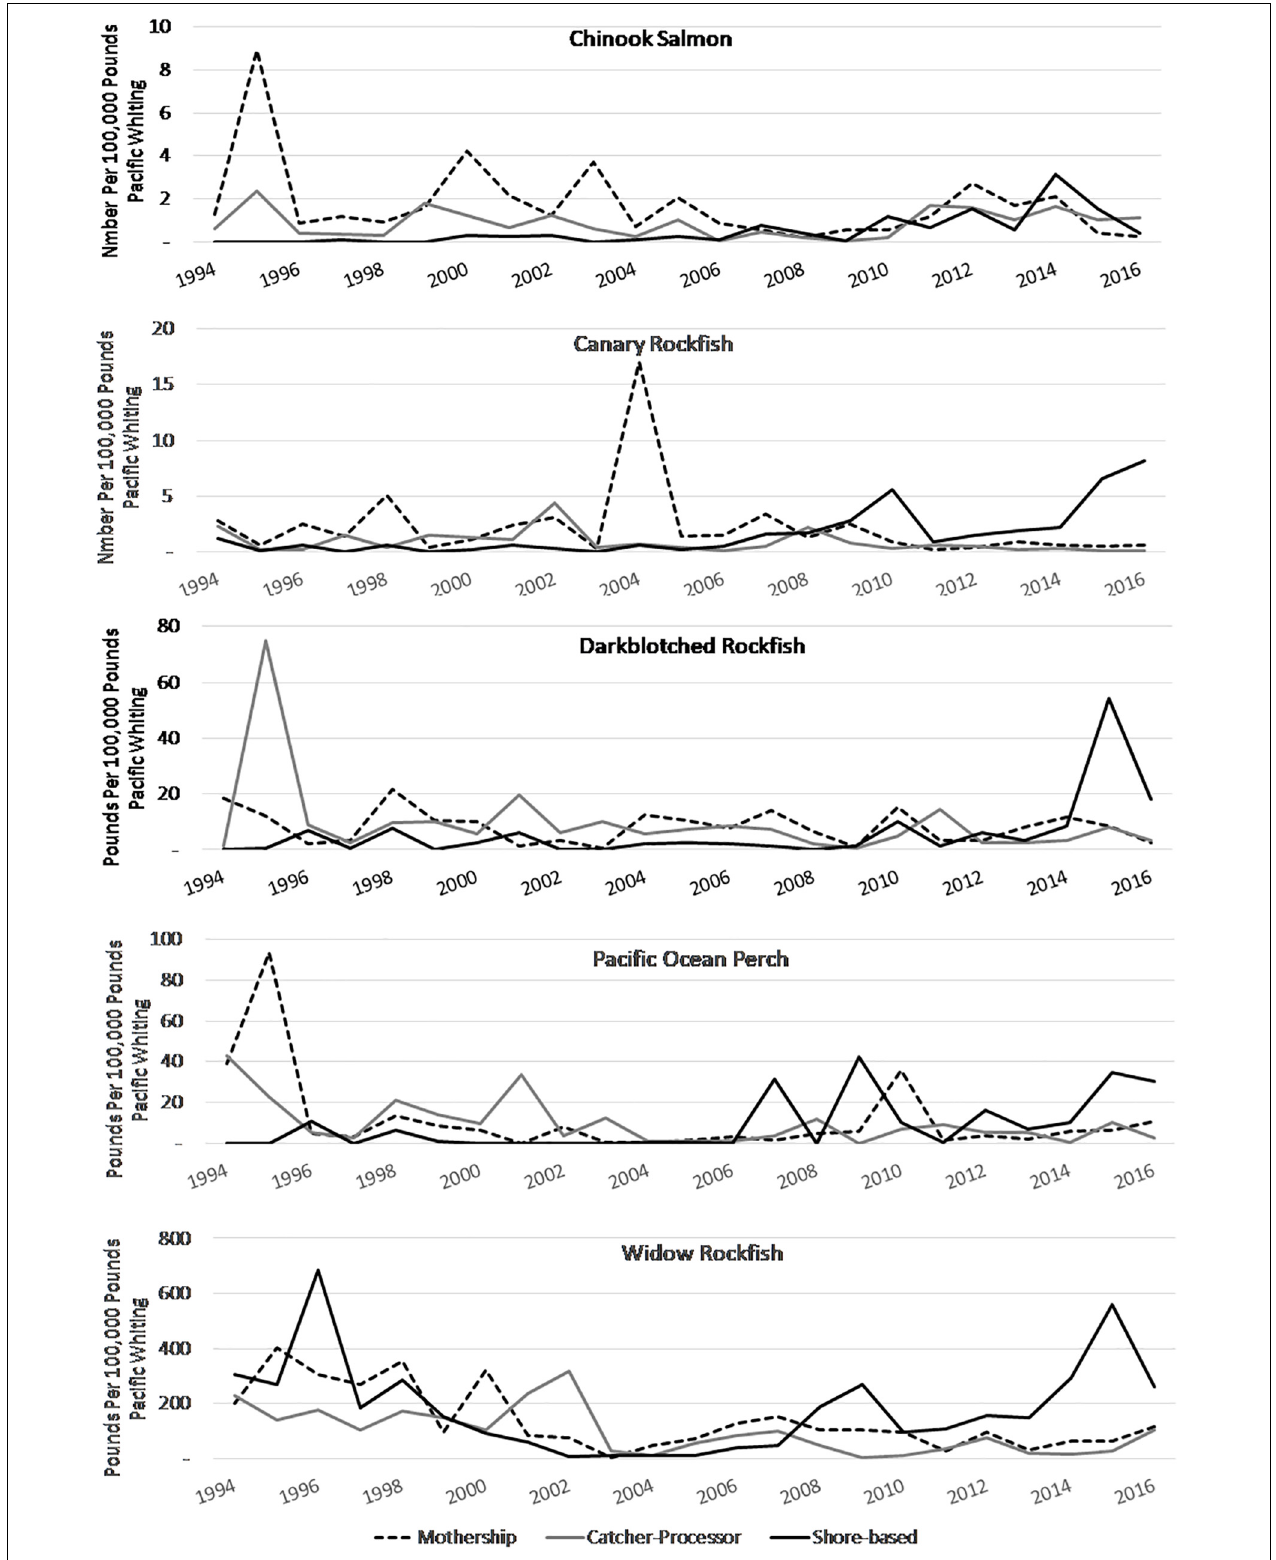
FIGURE 1 | Bycatch rates for different sectors of the US Pacific whiting fishery.